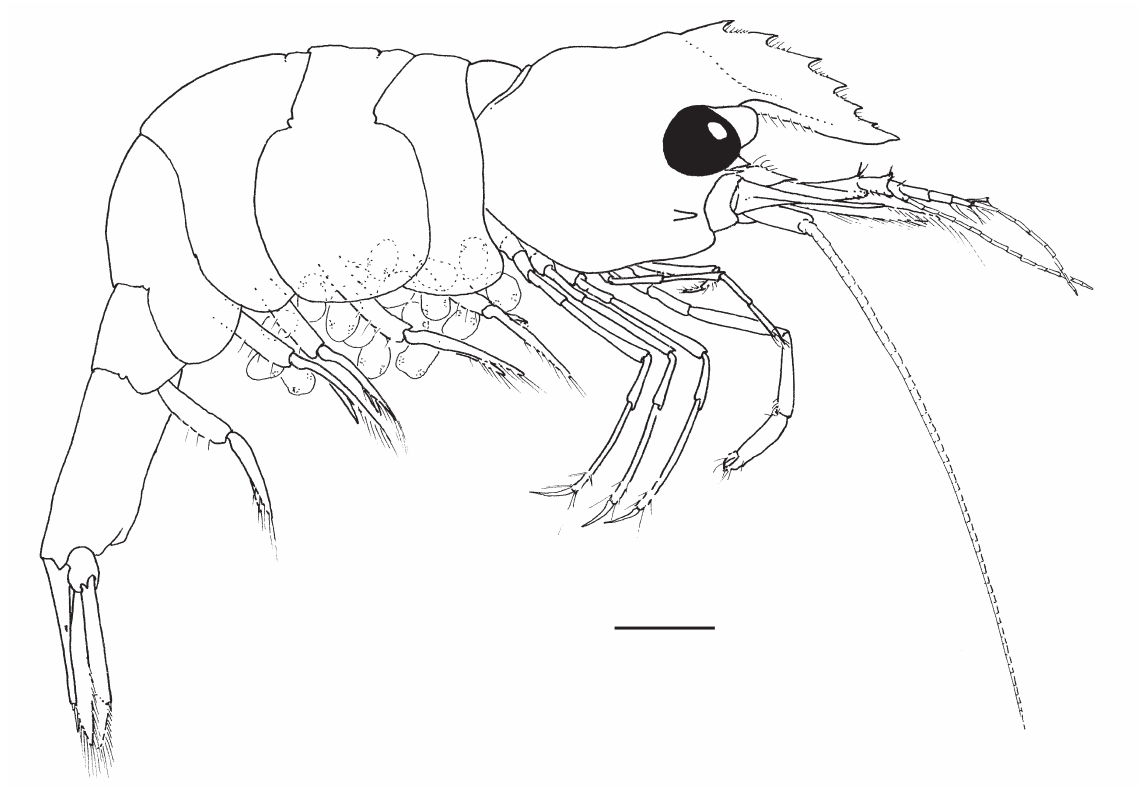
Fig. 6. Hamodactylus pseudaqabai sp. nov., ovigerous ♀ , holotype (PoCL 2.0 mm, N. Sulawesi, RMNH. CRUS.D.57195), habitus, lateral view. Scale bar = 1